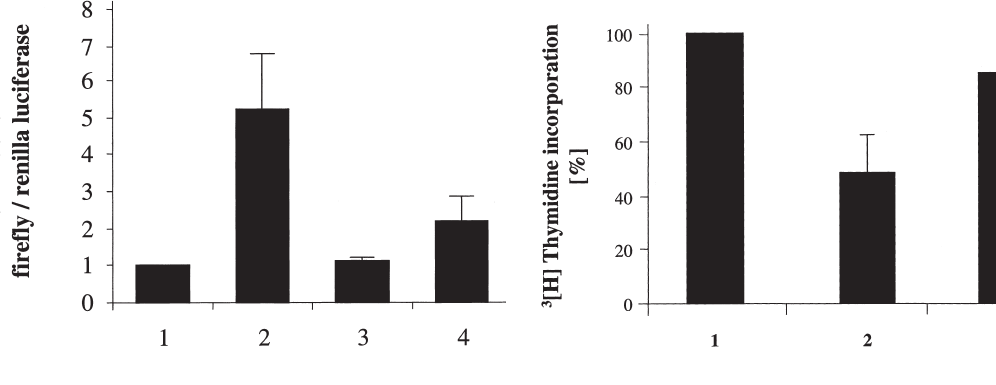
Figure 5 Functional consequences of inhibition of MHC class II anti- gens by simvastatin on T lymphocyte